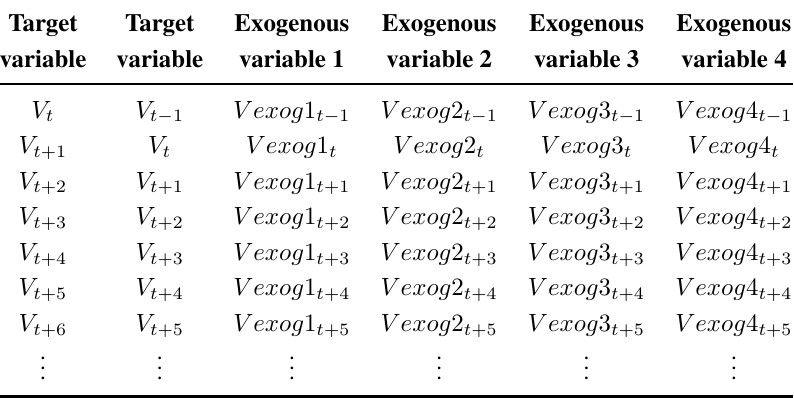
Table 6. Example of the autoregressive matrix.